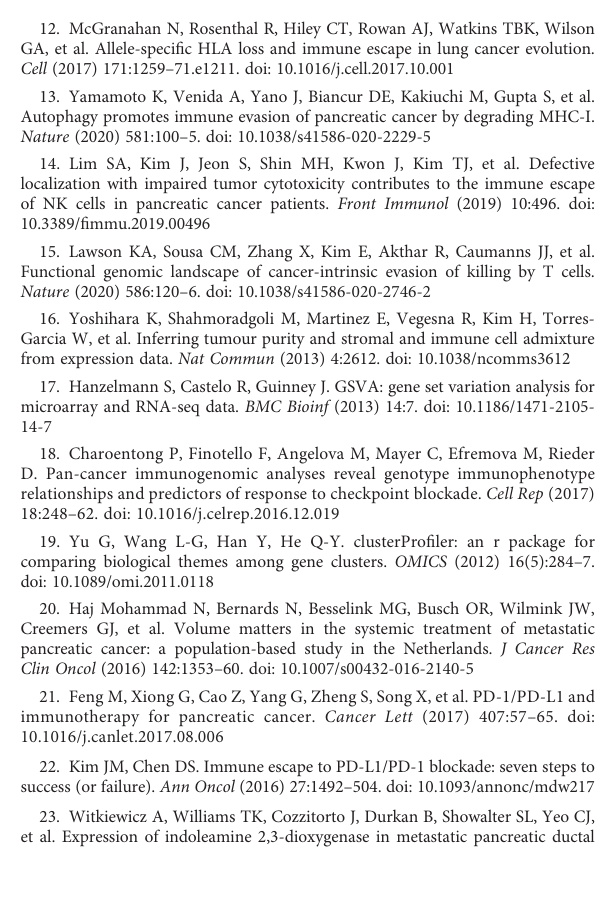
SUPPLEMENTARY FIGURE 1 Kaplan-Meier curves of IEGPI score in six datasets involving in the training cohort. SUPPLEMENTARY FIGURE 2 The distribution of IEGPI score in different immunotherapy response